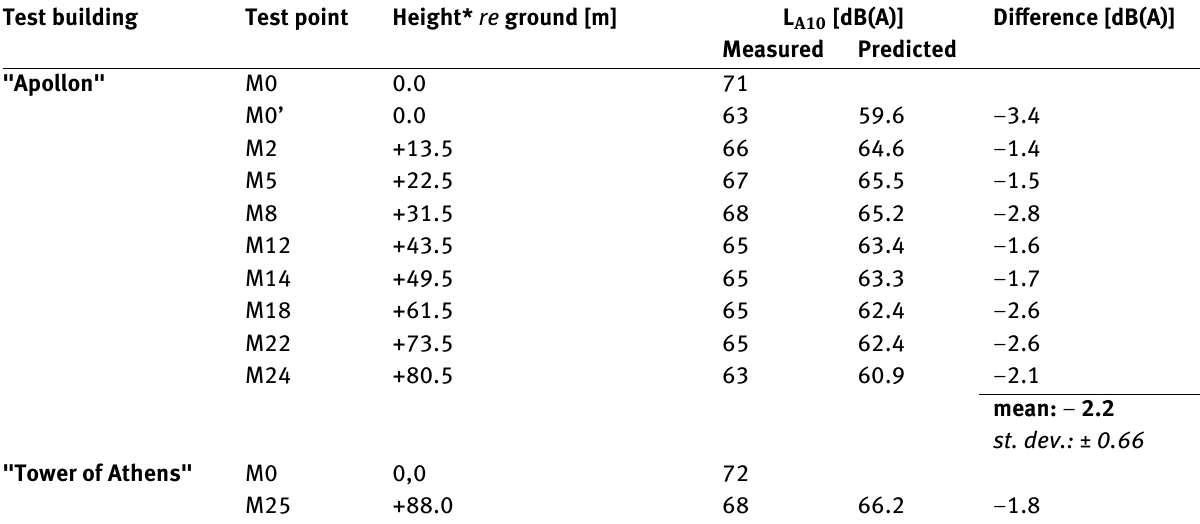
Table 2: Difference between measured and predicted traflc noise levels along the test buildings façade Test building